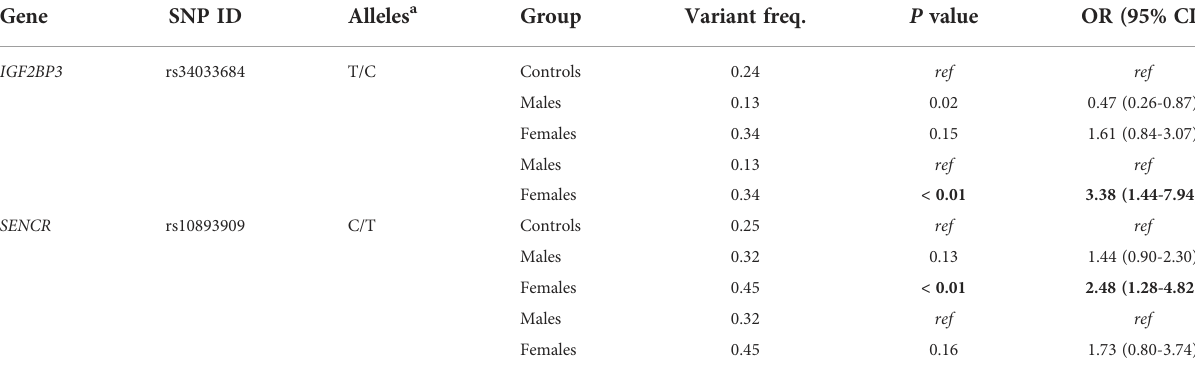
Male and female subgroups were compared with control group and between each other. a Major allele fi rst.